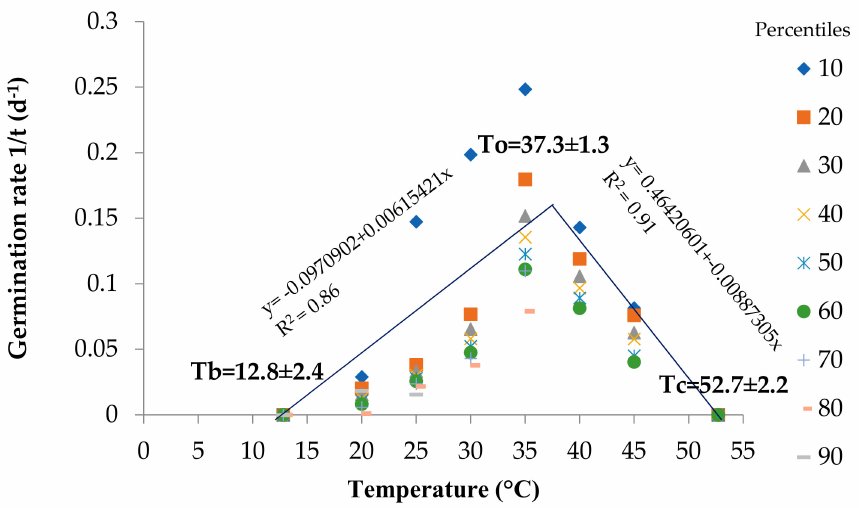
Figure 3. Germination rate in percentiles (inverse of germination speed) for each temperature de- scribing the cardinal temperatures of S. macrophilla , (Tb: Base temp; To: Optimal temp; Tc: Maximum temperature). Regressions are based on all percentiles.